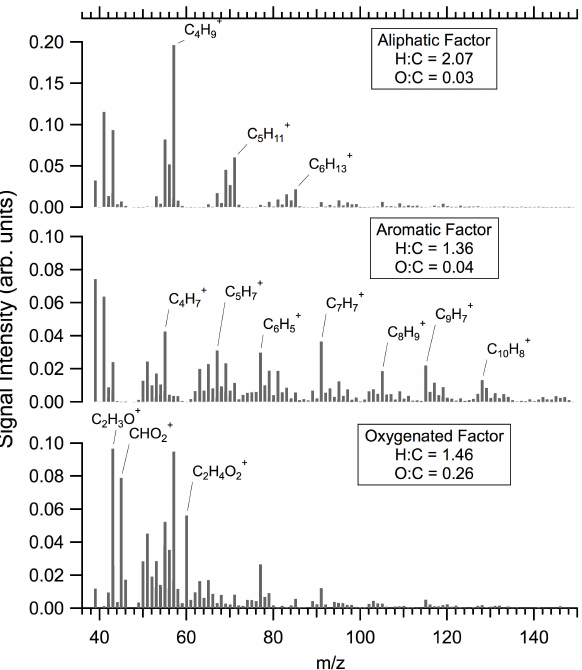
Fig. 8b. Aliphatic, aromatic, and oxygenated PMF factor mass spec- tra and O:C and H:C ratios for